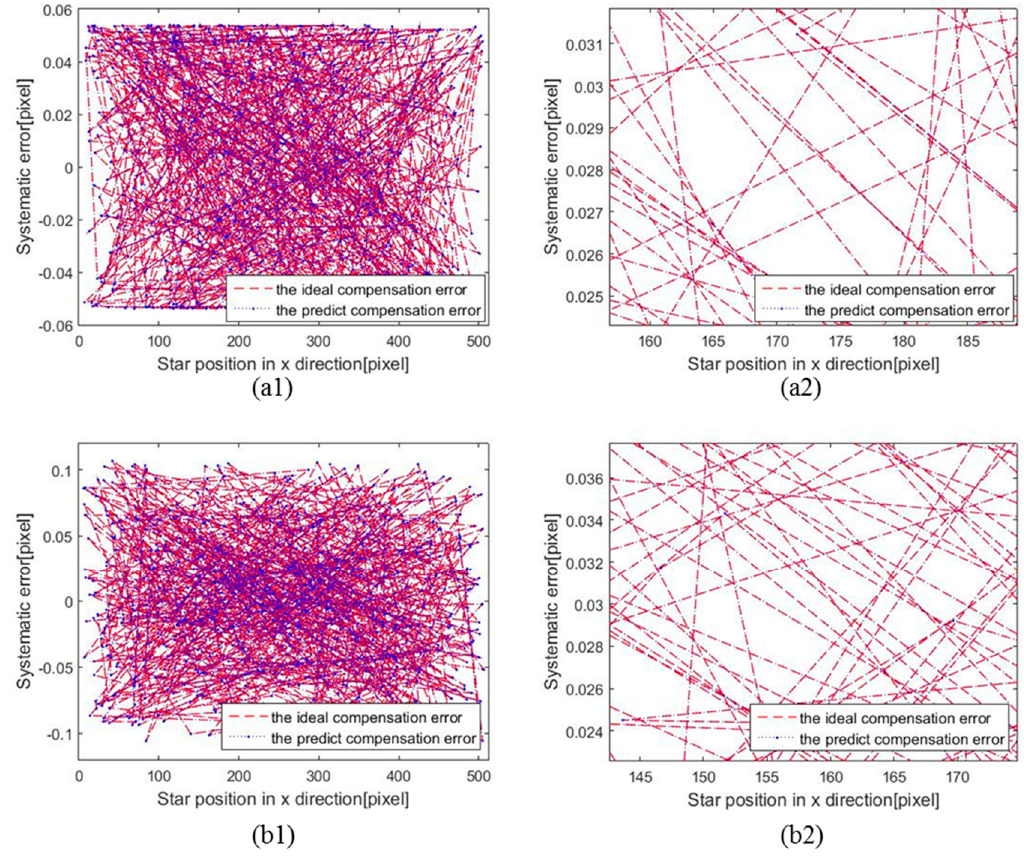
Figure 10. Experiment results of random positions. ( a1 , a2 ) Gaussian width σ PSF = 0.3. ( b1 , b2 ) Gaussian width σ PSF = 0.671.